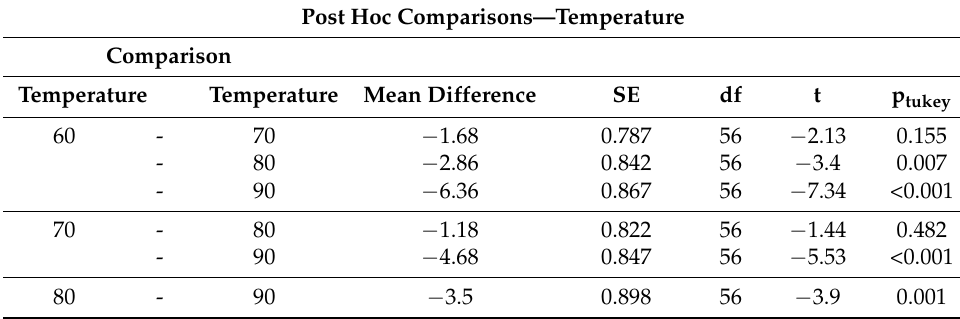
Table A2. Tukey test for temperature treatments in pectin yield